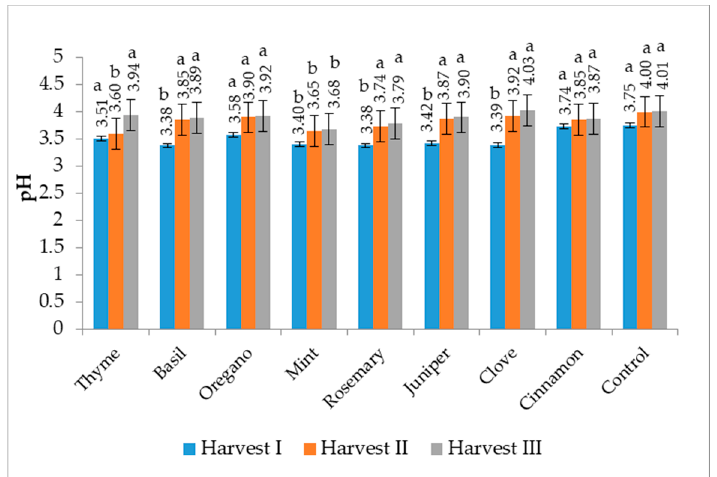
Figure 5. pH evolution of the samples before (Harvest I), after (Harvest II) the use of EOs in the supplementary feed of bee families, respectively after the first harvest (rapeseed) (Harvest III). Different letters between control and samples indicate significant differences ( p < 0.05) among these values according to the t -test.